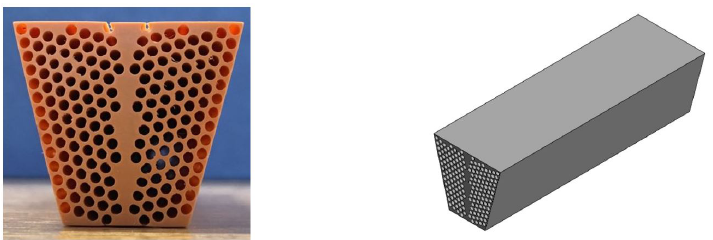
Figure 3. Slot former used for the experimental motorette: ( Left ) 3D printed slot former; ( Right ) 3D render of the slot former.